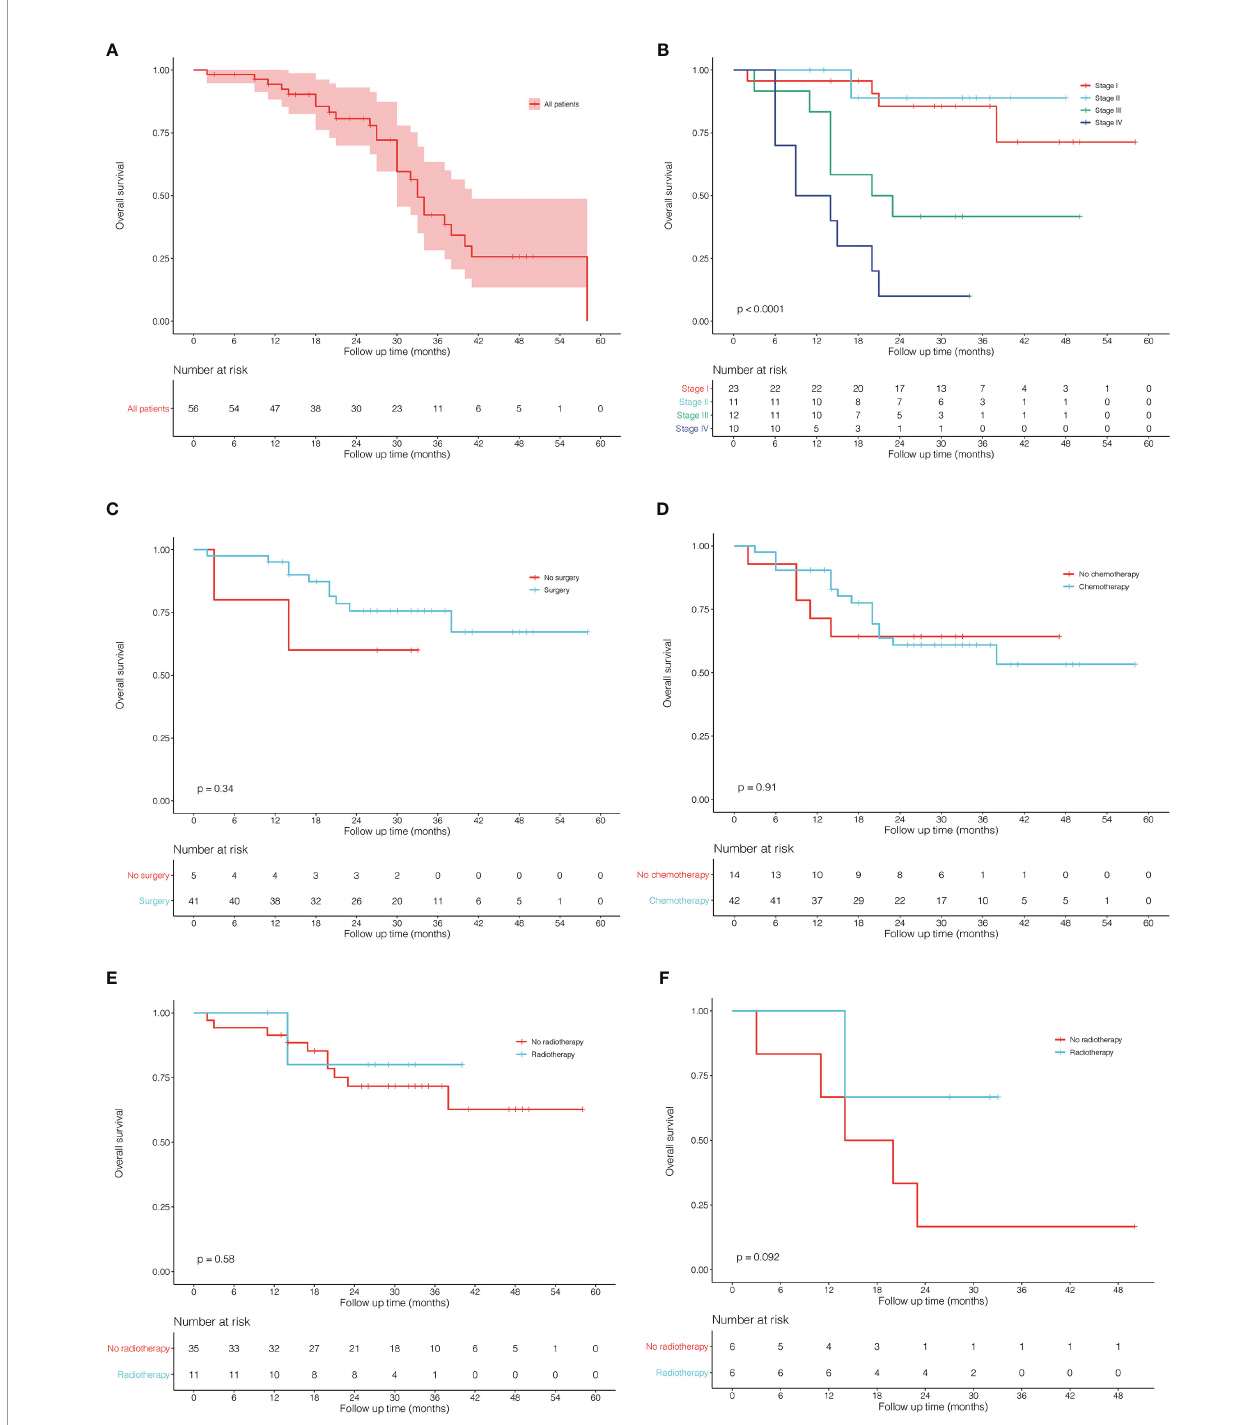
FIGURE 1 | Kaplan – Meier curves for overall survival in patients with pulmonary large cell neuroendocrine carcinoma from Peking Union Medical College Hospital. (A) all 56 patients. (B) comparison between different stages. (C) surgery vs no surgery in stage I-III patients. (D) chemotherapy vs no chemotherapy in all patients. (E) radiotherapy vs no radiotherapy in all patients. (F) radiotherapy vs no radiotherapy in stage III